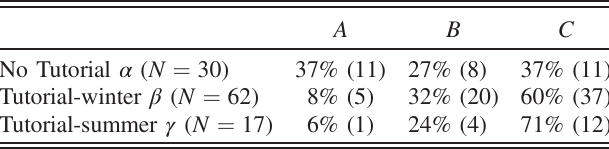
TABLE V. Responses to question 3 (Fig. 3) administered at the end of a quarter of junior-level quantum mechanics